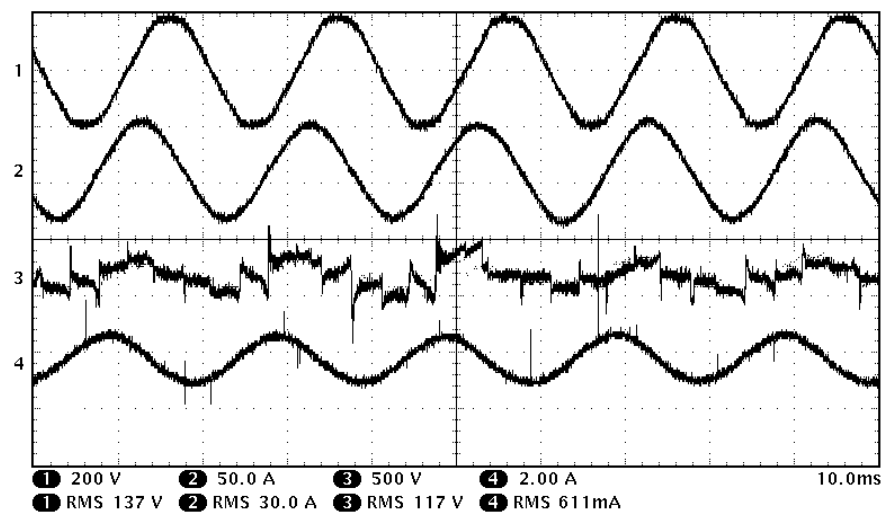
Figure 10. Current and voltage waveforms of the IFCTPS power supply, 1 — input voltage, 2 — input current, 3 — output voltage, 4 — output current, plasma gas: argon, flow: 2.8 m 3 /h.